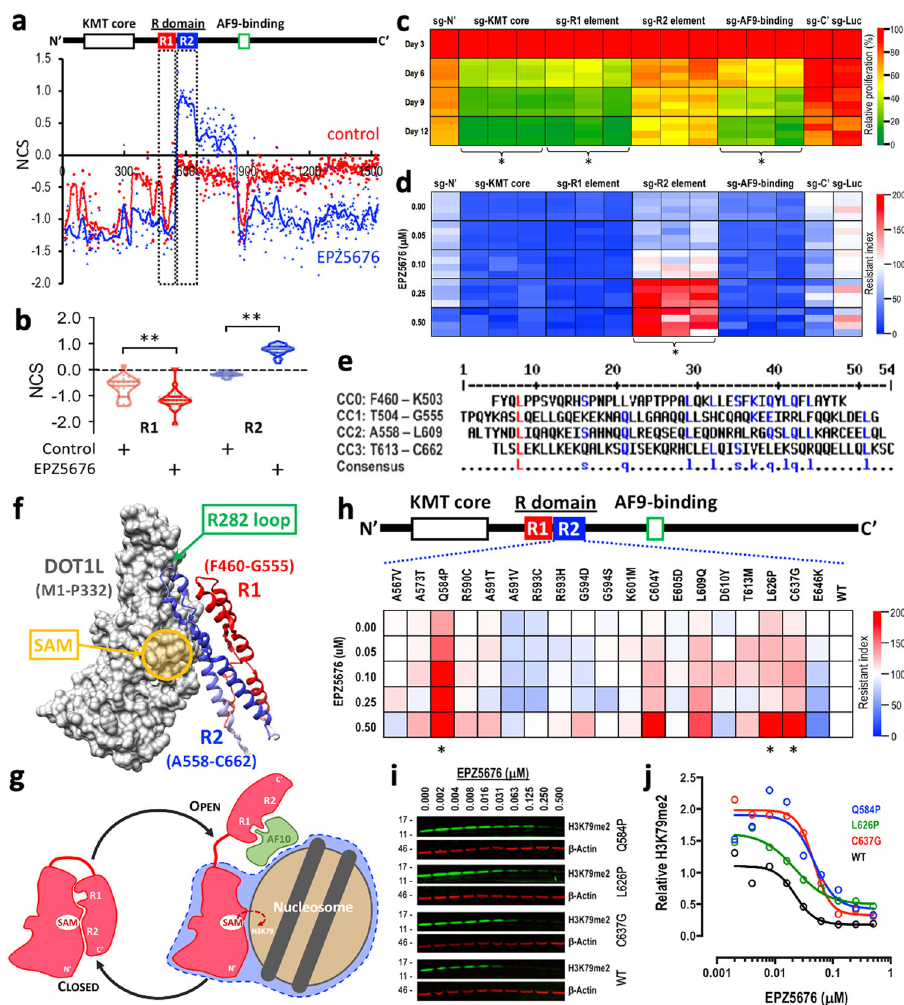
Fig. 3 sc-Tiling identi fi es noncanonical EPZ5676-resistant alleles in the human population. a Normalized CRISPR score (NCS) of each sgRNA construct (dots) and the smoothed score (line) of the pooled DOT1L-tiling survival screen before vs. after 12 days of treatment in control (red) or 1 µ M EPZ5676- treated (blue) MLL-AF9-Cas9 + leukemia cells. Data represent the average of a triplicate experiment. b Violin dot plots showing the NCS of each sgRNA targeting the R1 (red; 27 sgRNAs) and R2 (blue; 36 sgRNAs) elements in control (DMSO) or 1 µ M EPZ5676-treated MLL-AF9-Cas9 + leukemia cells. ** P < 0.001 by two-sided Student ’ s t test. c Heatmap showing the effect of individual sgRNAs targeting the indicated areas of DOT1L (Supplementary Fig. 6) on the proliferation of MLL-AF9-Cas9 + leukemia cells on days 3, 6, 9, and 12. Data represent the observed values of a quadruplicate experiment. *Signi fi cantly ( P < 0.01 by two-sided Student ’ s t test) more depletion compared to the sgRNA targeting a non-essential N ʹ region (sg-N ʹ ) on day 12. d Heatmap showing EPZ5676 resistance index of MLL-AF9-Cas9 + leukemia cells transduced with sgRNAs targeting the indicated areas of DOT1L (Supplementary Fig. 6). Data represent the observed values of a quadruplicate experiment. *Signi fi cantly ( P < 0.01 by two-sided Student ’ s t test) higher resistance compared to sg-N ʹ at 0.5 µ M EPZ5676. e Peptide sequence alignment of the R domain (residues F460 – C662) in human DOT1L. The predicted alpha-helices in this coiled-coil domain are designated CC0 – CC3 and the consensus residues between the helixes are noted. f Computationally modeled structure of the human DOT1L R1 (red) and R2 (blue) coiled-coil domains interacting with the KMT core domain (gray; PDB ID: 3UWP) 46 . g Cartoon representation of the R1/R2 self- regulatory module mediating the closed (left) vs. open (right) states of DOT1L. h Heatmap showing EPZ5676 resistance index of MLL-AF9 leukemia cells transduced with human DOT1L cDNA harboring clinically observed variants (from cBioPortal database) in the R2 element. Data represent the averaged values of a quadruplicate experiment. *Signi fi cantly ( P < 0.01 by two-sided Student ’ s t test) higher resistance compared to wild-type at 0.5 µ M EPZ5676. i Western blot images of H3K79me2 (green) and β -actin (red) and ( j ) quantitative measurement of relative H3K79me2 level (normalized to β -actin) in MLL-AF9 leukemia cells transduced with wild-type (WT; black), Q584P (blue), L626P (green), or C637G (red) human DOT1L cDNA. Cells were treated with EPZ5676 for 3 days. Source data are available in the Source Data fi concerns in the CRISPR sc-Tiling approach, by considering resolution in detecting sub-domain functional elements than multiple sgRNAs clustered in a peptide region via a local- survival CRISPR gene-tiling screens using pooled sequencing (i.e., smoothing strategy, we signi fi cantly increased the statistical Fig. 1g vs. 2b; KMT core). Furthermore, when we coupled sc- con fi dence and minimized the impact of noise associated with Tiling with three-dimensional structural modeling, we discovered individual sgRNAs. Importantly, the use of single-cell transcrip- a self-regulatory R domain in DOT1L that modulates chromatin tional pro fi ling in sc-Tiling could predict functional elements and interaction, enzymatic activation, and therapeutic sensitivity in corresponding gene regulations that led to a cellular survival MLL -r leukemia. To our knowledge, this is the fi rst character- phenotype after prolonged culture, and provided superior ization of an intragenic regulatory module that mediates